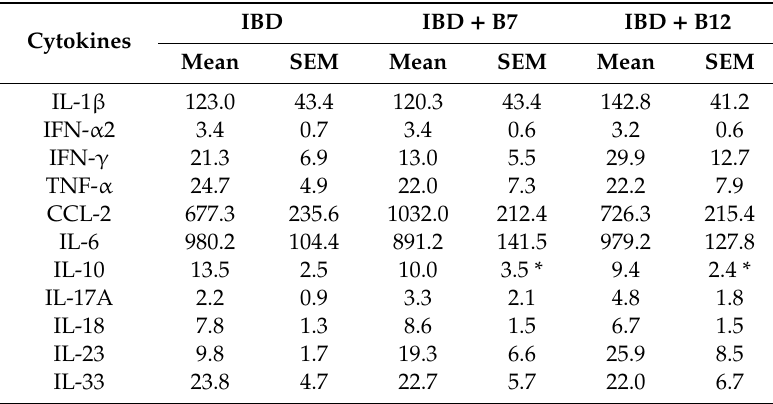
Table 1. Peptide e ff ect over the intestinal cytokine